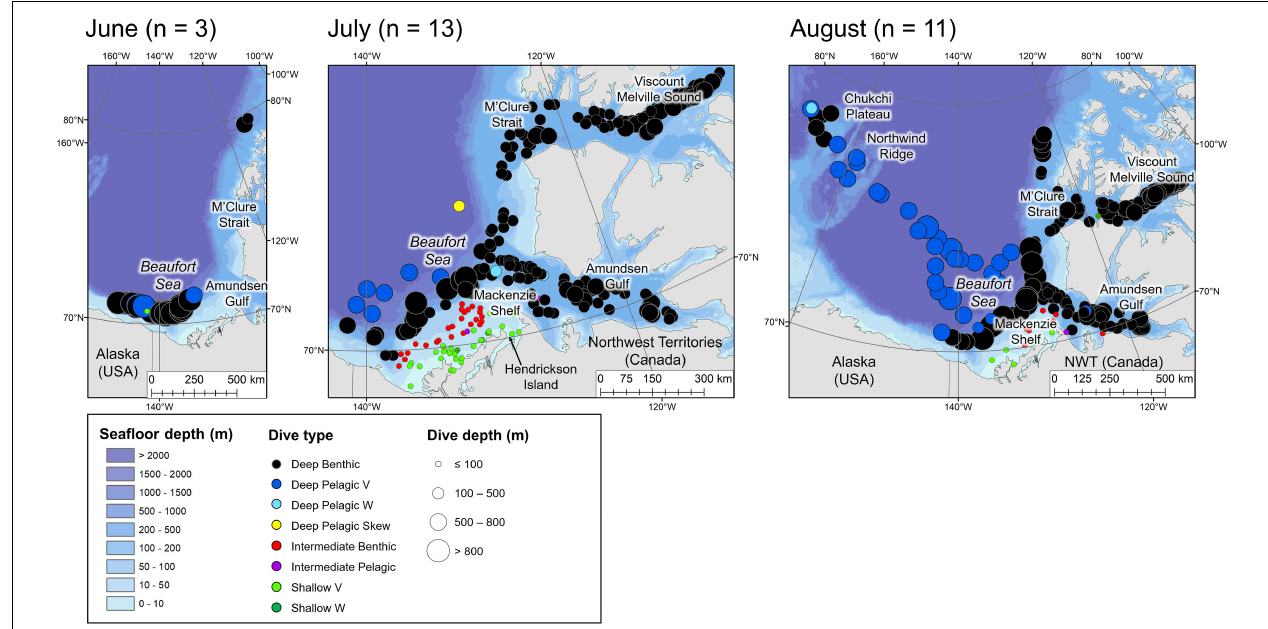
FIGURE 3 | Locations of the daily deepest dive made by each beluga during the summer months. Symbol color represents dive type and symbol size represents the maximum depth reached. n in parentheses gives the number of belugas which transmitted data in the given month. Note that the panel for June denotes locations of dives recorded in 2019 (made by belugas which were tagged in July 2018). July and August are for 2018 and 2019.